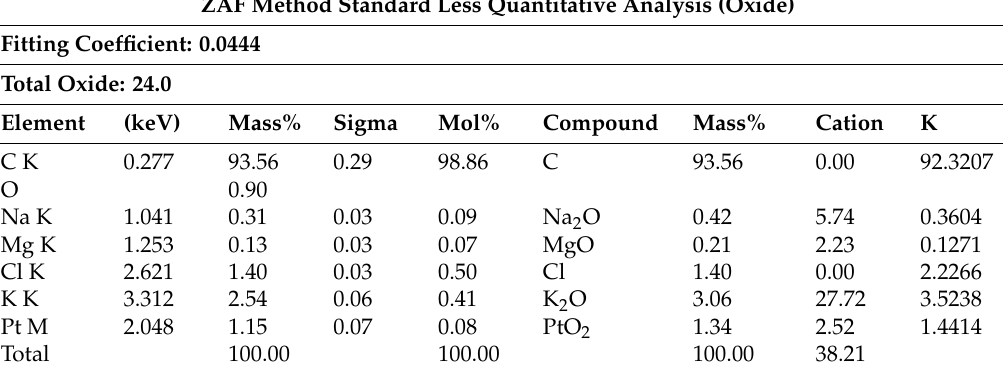
Table 5. Oxide analysis of Placuna placenta